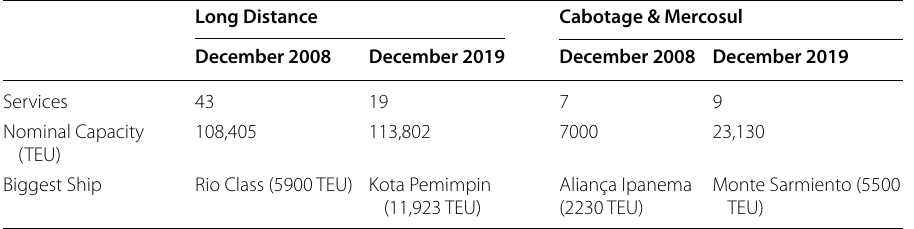
Table 6 Long Distance and Cabotage in